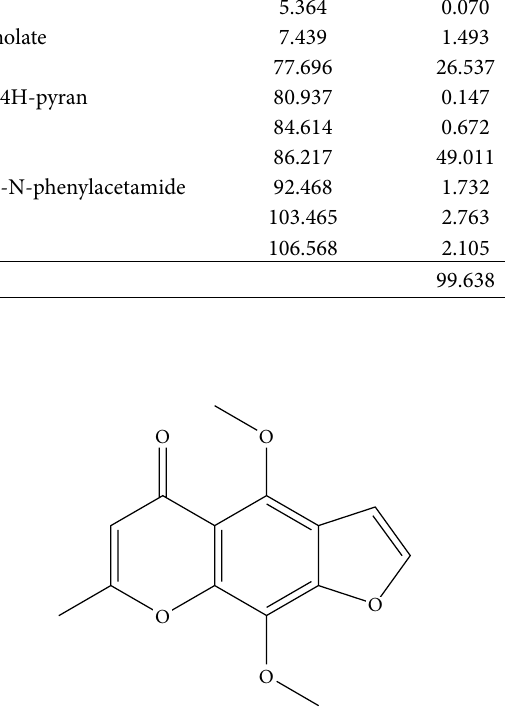
Figure 1: Chemical structure of Khellin.